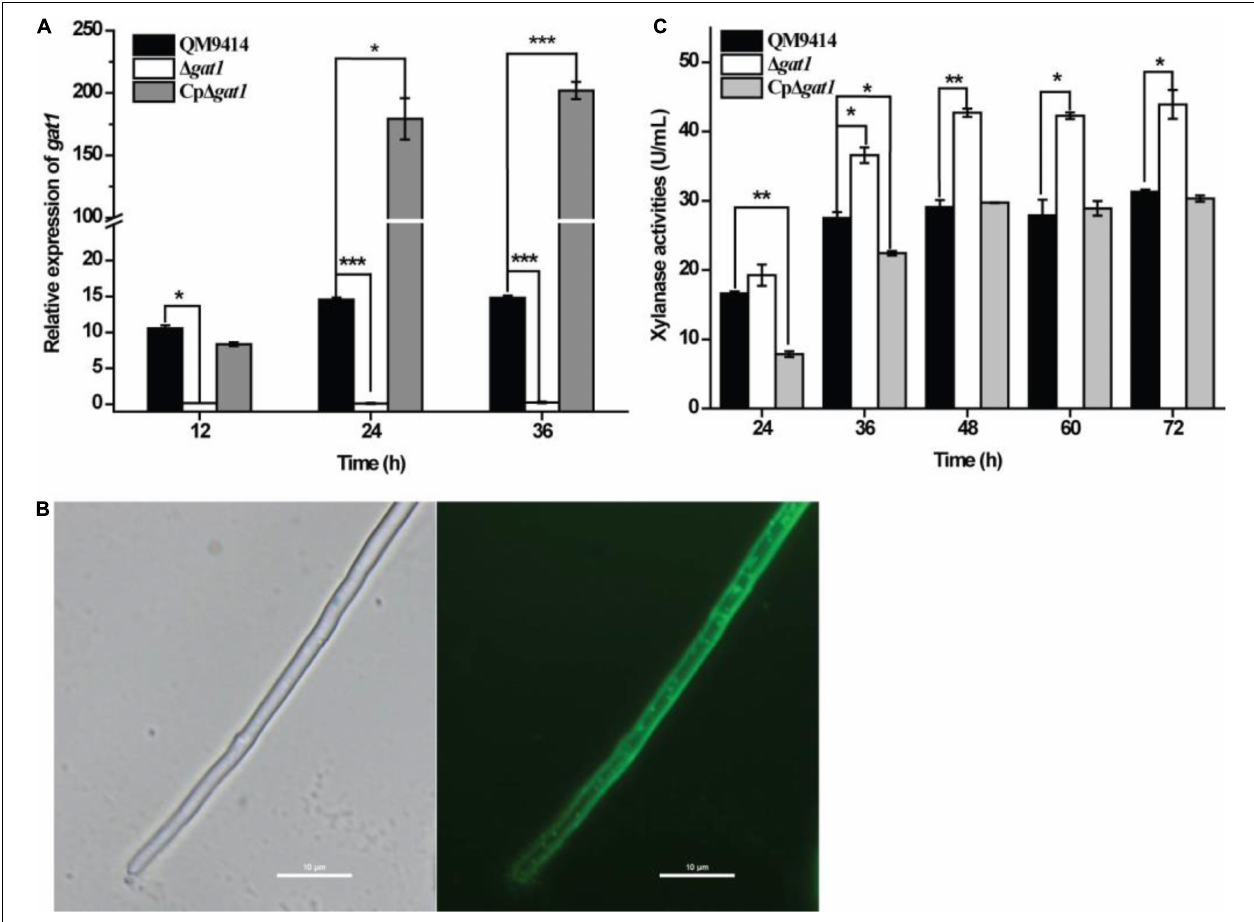
FIGURE 2 | Complementation of (cid:49) gat1 with gat1-gfp overexpression reverted the elevated xylanase activity to the level of QM9414. (A) Quantitative RT-PCR analyses of the relative transcriptional levels of gat1 in QM9414, (cid:49) gat1 , and Cp (cid:49) gat1 cultivated on 0.5% xylan. (B) Fluorescence microscopic analyses of Cp (cid:49) gat1 expressing gat1 - gfp after cultivation on minimal medium containing 1% glucose for 16 h. (C) Xylanase activity analyses of the culture supernatant from QM9414, (cid:49) gat1 and Cp (cid:49) gat1 strains cultivated on 0.5% xylan. Values in this figure are the mean of three biological replicates. Error bars are the SD from these replicates. Significant differences ( t -test, * P < 0.05, ** P < 0.01, and *** P < 0.0001) were detected in the transcriptional level of gat1 and xylanase activities between QM9414 and (cid:49) gat1 or between QM9414 and Cp (cid:49) gat1